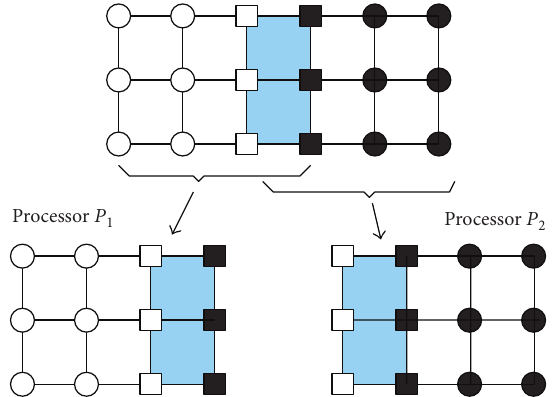
F 2: Vertex-oriented decomposition. Example of the overlapping stripe and respective mapping onto processors p and q , update and external nodes. For